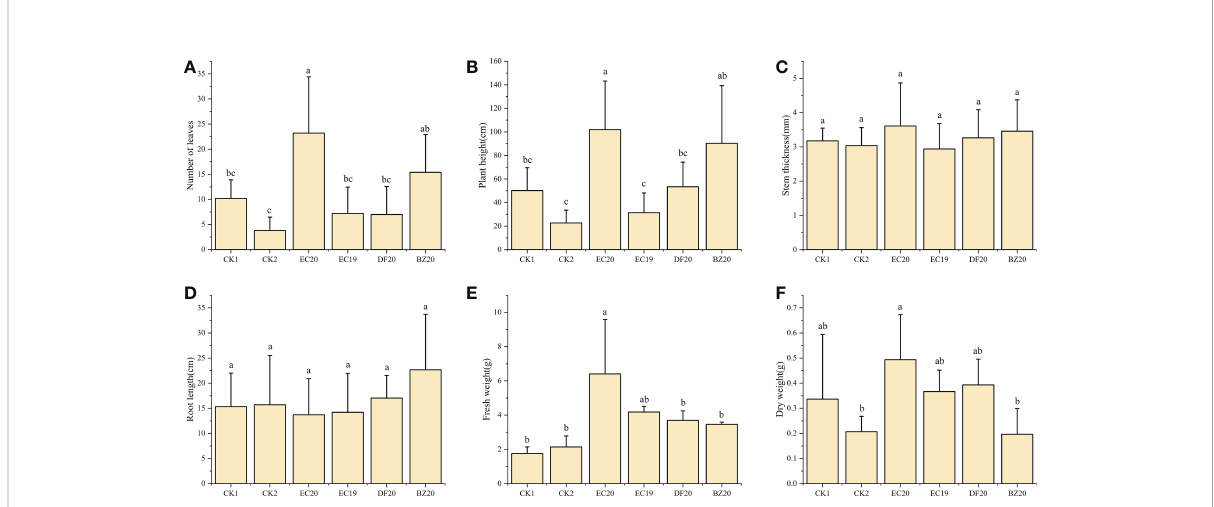
FIGURE 4 Effect of bio-fertilizer on phenotypic indicators of cowpea: (A) number of leaves; (B) plant height; (C) stem thickness; (D) root length; (E) fresh weight; (F) dry weight. Data represent the mean ± SD of at least three independent experiments, and different lowercase letters indicate that differences between different treatment groups reached signi fi cance at the P<0.05